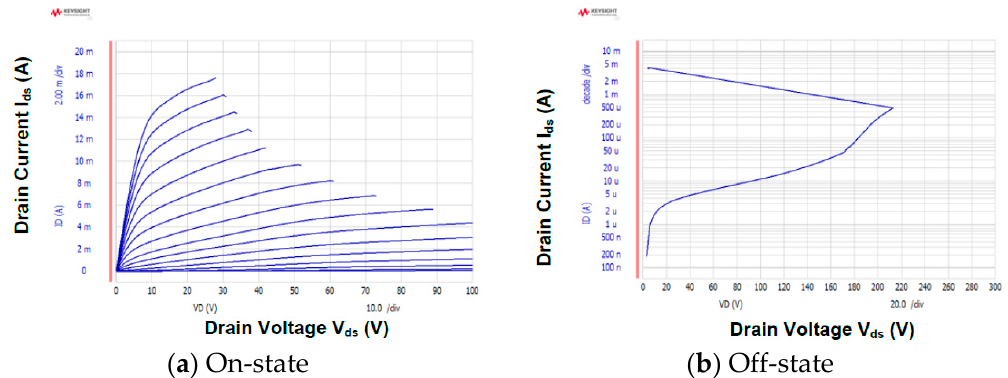
Figure 16. ( a ) On-state and ( b ) off-state I ds - V ds characteristics of the DMOSFET (L g = 0.4 μ m and W g = 100 μ m). The blocking voltage at off-state was 213 V.